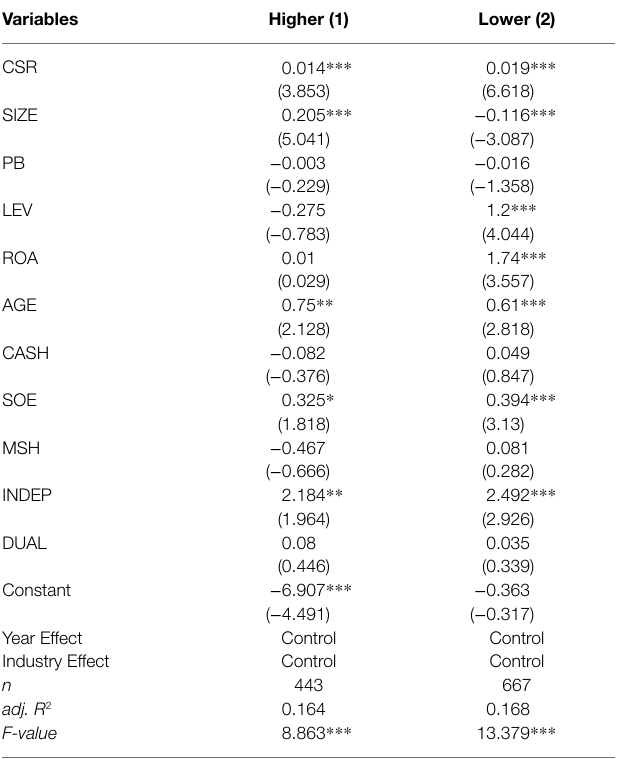
TABLE 6 | Exclusion for political uncertainty.